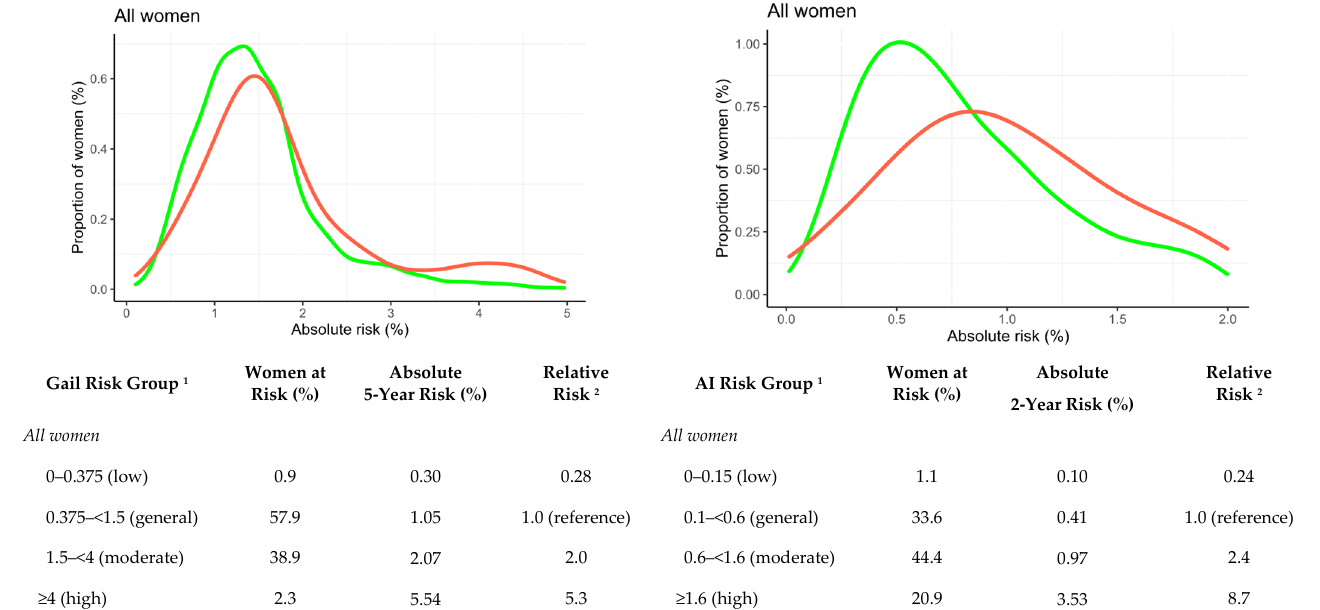
Figure 3. Frequency distribution of Gail 5-year (left column) and AI 2-year (right column) absolute risk scores for developing breast cancer in cases (red) and controls (green). Distributions presented for a subset of n = 166 breast cancer cases and n = 4894 controls with available Gail and AI risk scores. 1 Cut-offs for general, moderate, and high-risk groups are based on the NICE guidelines for 10-year risk in age group 40–50 (<3%, 3–8%, >8%) adapted to 5-year and 2-year, respectively, by dividing the 10-year risk by 2 and 5. We added a fourth low-risk group with the absolute risk cut-off 0.15 2- absolute risk category. High-risk women identified using Gail 18-fold higher risk compared with women at low risk. The corresponding numbers for AI Risk was 36-fold. NICE: National Institute of Health and Care Excellence guidelines.